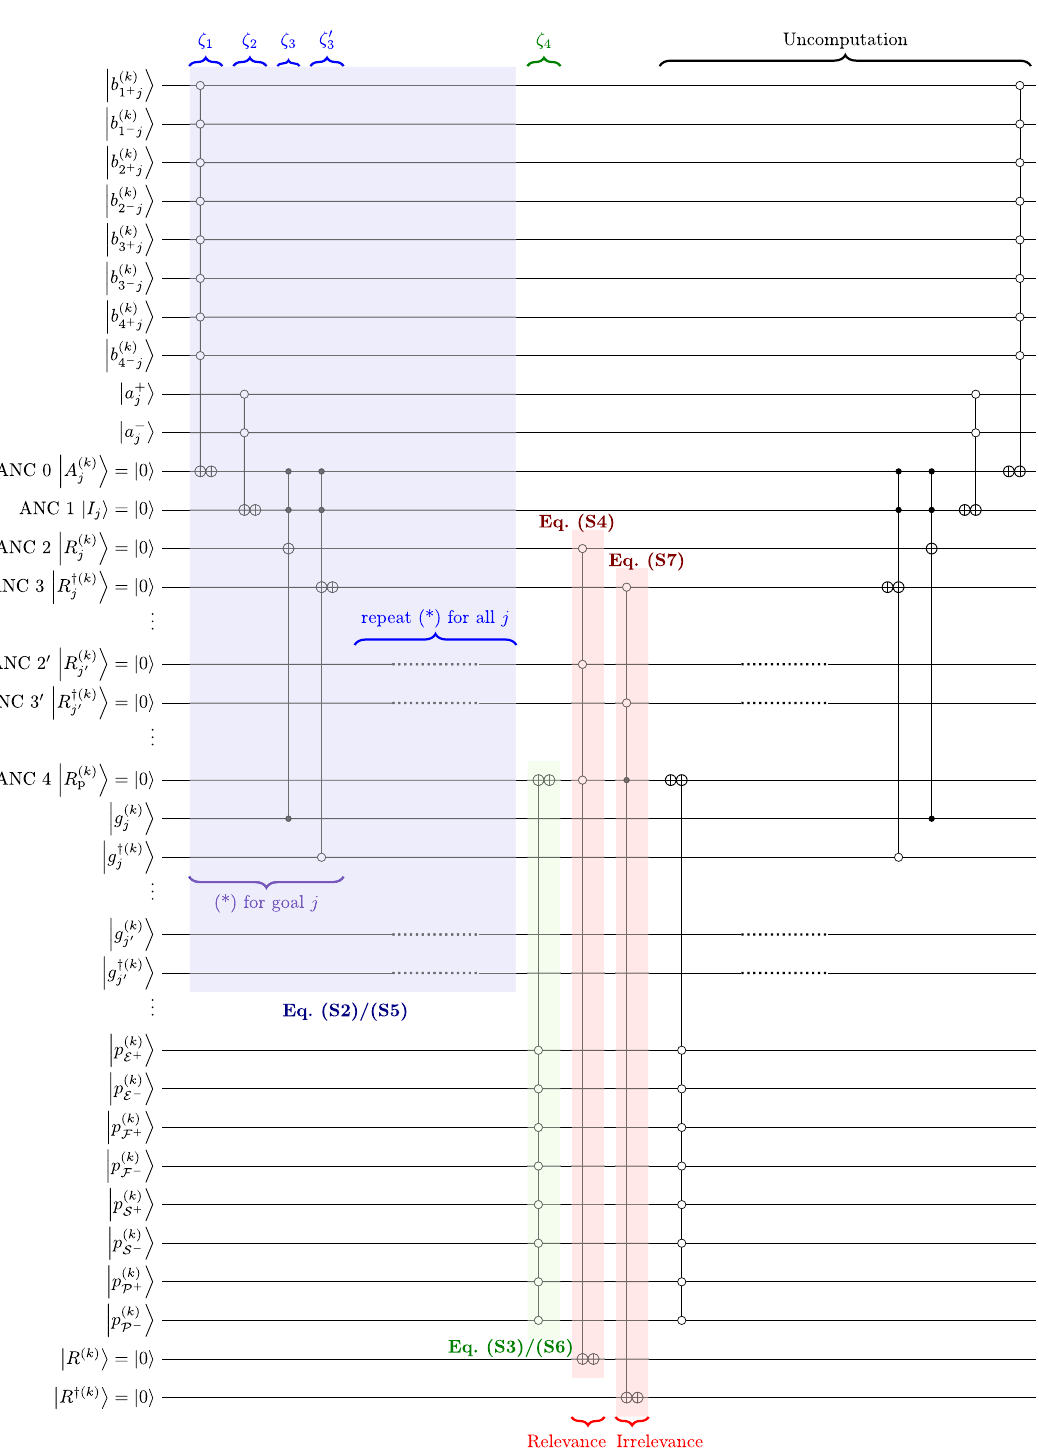
Figure 6. Algorithm for relevance generation. ζ 1 , ζ 2 , ζ 3 and ζ 4 refer to Eqs.